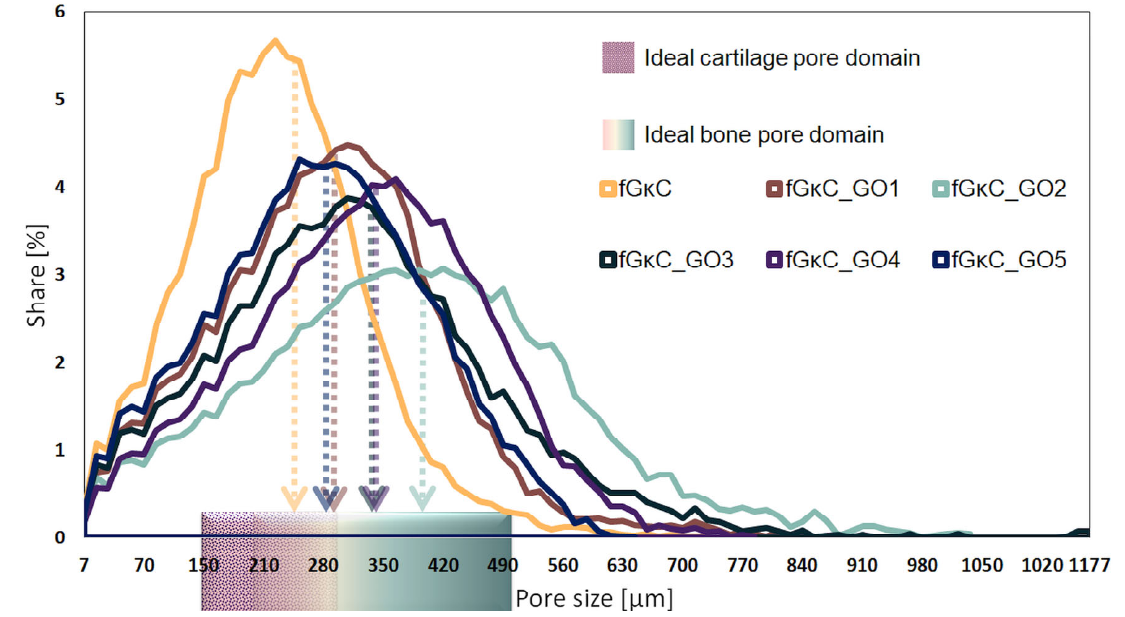
Figure 4. Superimposed pore size distribution of the synthesized materials against pore domains agreed [44,45] to better support cartilage and bone regeneration. Table 1. Total porosity and key pore features of the synthesized